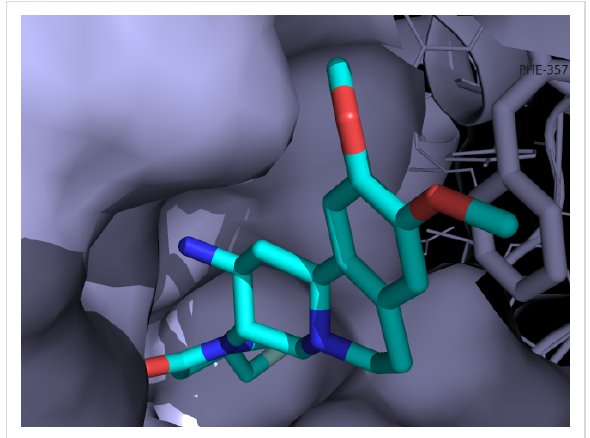
Figure 8: Co-crystal structure of carmegliptin bound in the human DPP-4 active site (PDB